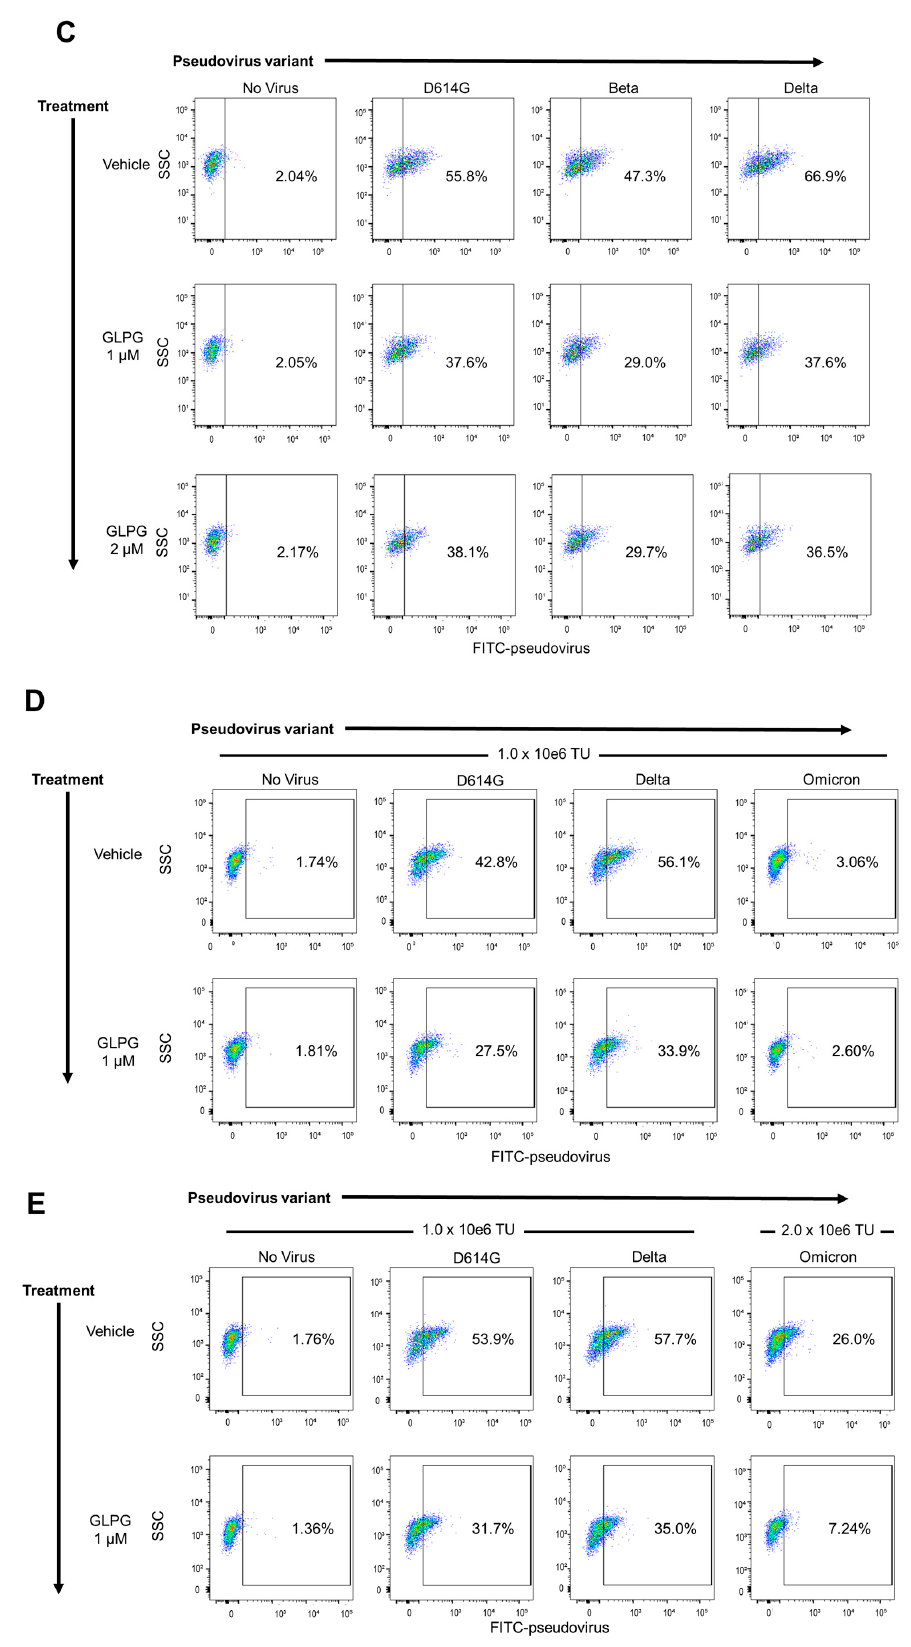
Figure 1. GLPG-0187 inhibits infection of SARS-CoV-2 pseudovirus variants D614, D614G, N501Y, E484K, N + E, NEK, R685A, Beta, Delta, and Omicron in small airway epithelial cells. ( A )